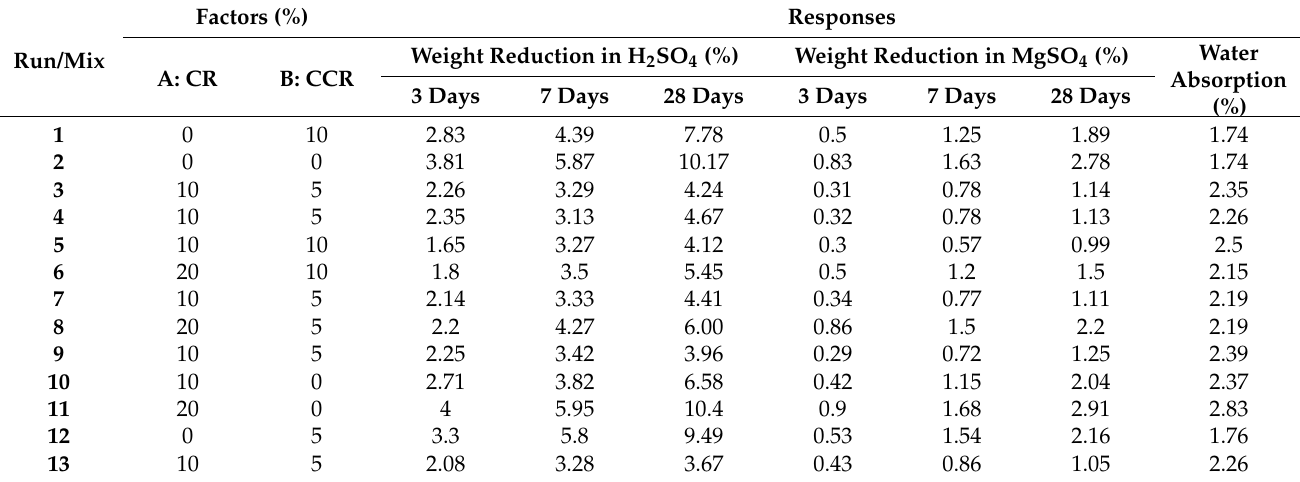
Table 3. Results of durability test on SCC